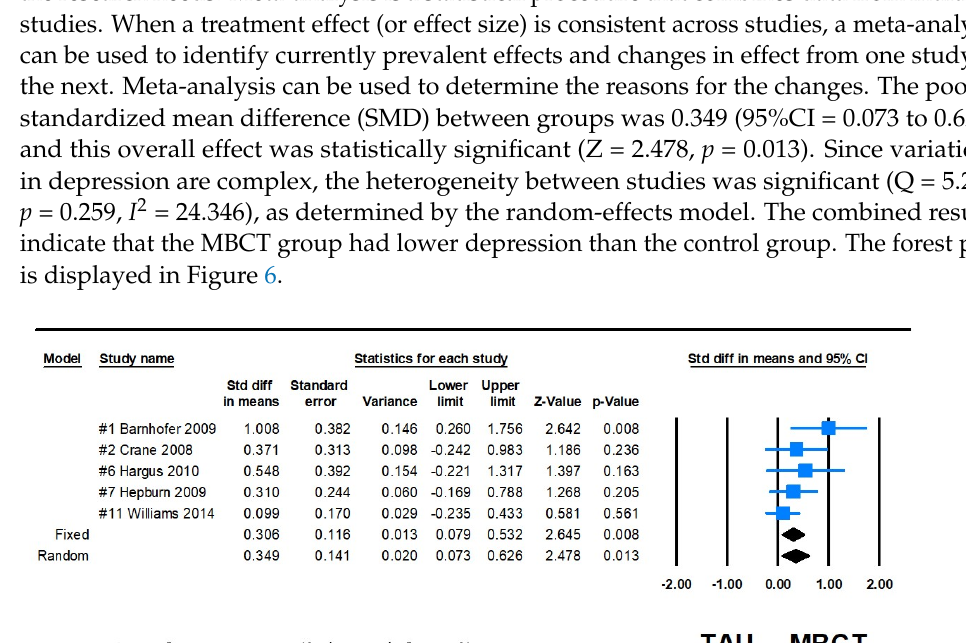
effects model. The combined results indicate that the MBCT group had lower depression than the control group. The forest plot is displayed in Figure 7.